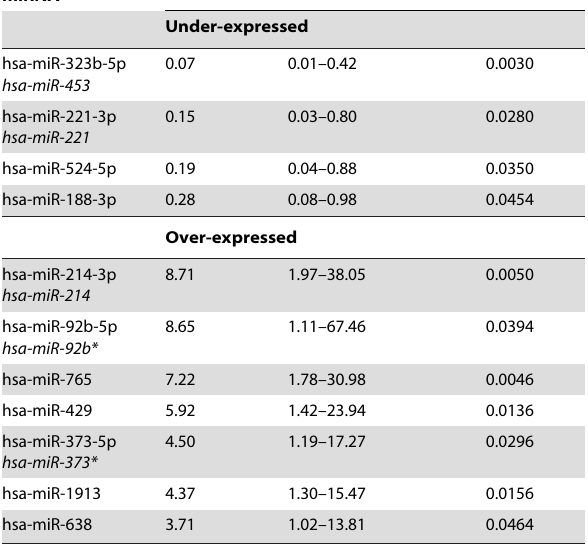
Table 2. Differentially expressed miRNAs between albuminuric and non-albuminuric (reference) samples from patients with MA.